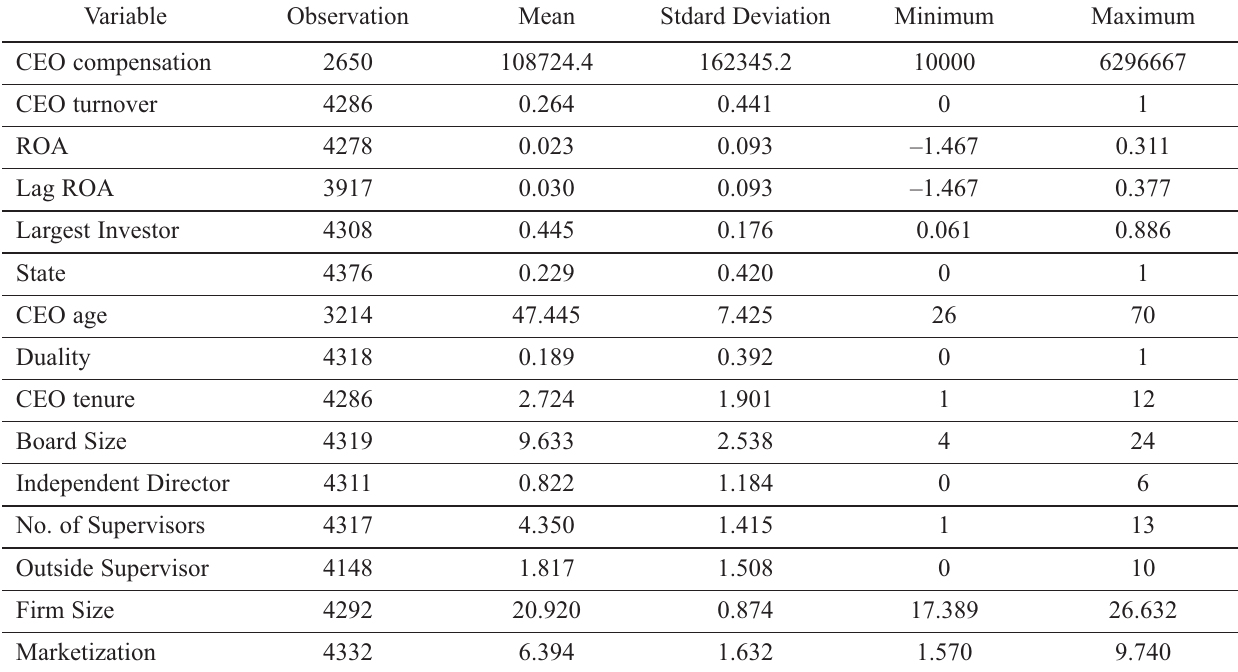
Table 1. Summary statistics of key